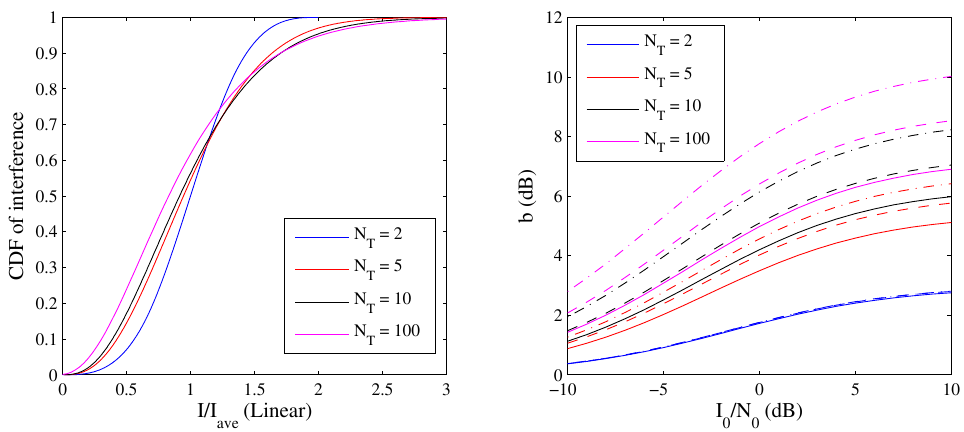
Figure 7. Effect of interferer precoder variation in multi-antenna system. Left: CDF of realized interference powers, relative to average interference, J = 3 interferers; Right: Backoff. Dash-dot line- J = 1, dashed line- J = 2 and solid line- J =